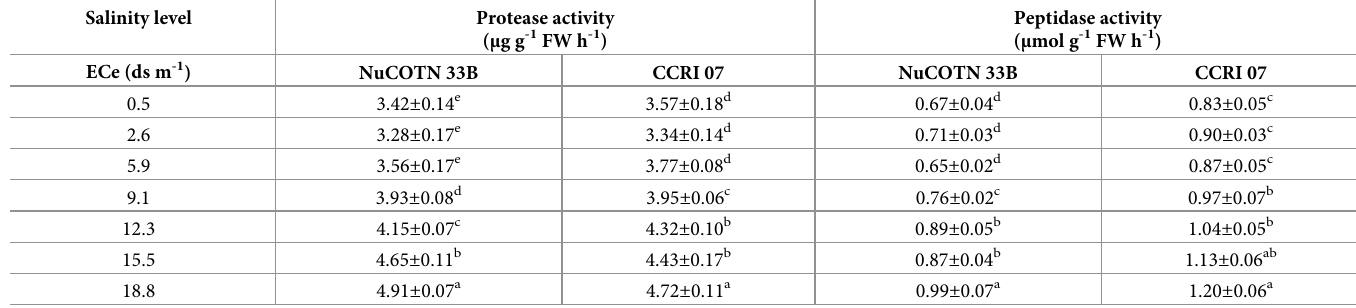
Table 5. Impacts of salinity on protease and peptidase activities in squares of two Bt cotton cultivars under greenhouse conditions in 2017 (n = 4). Different letters represent significant differences in the same column (Duncan multiple range tests, P < 0.05). Salinity level